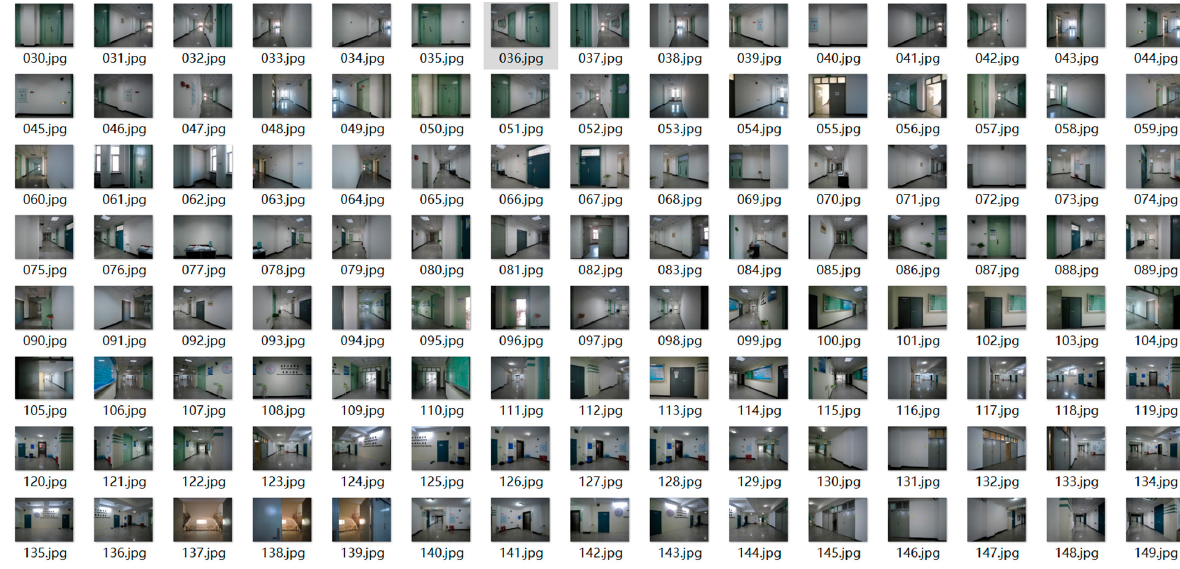
Figure 9. Example of the visual map. Table 2. Examples of partial annotations for visual map.